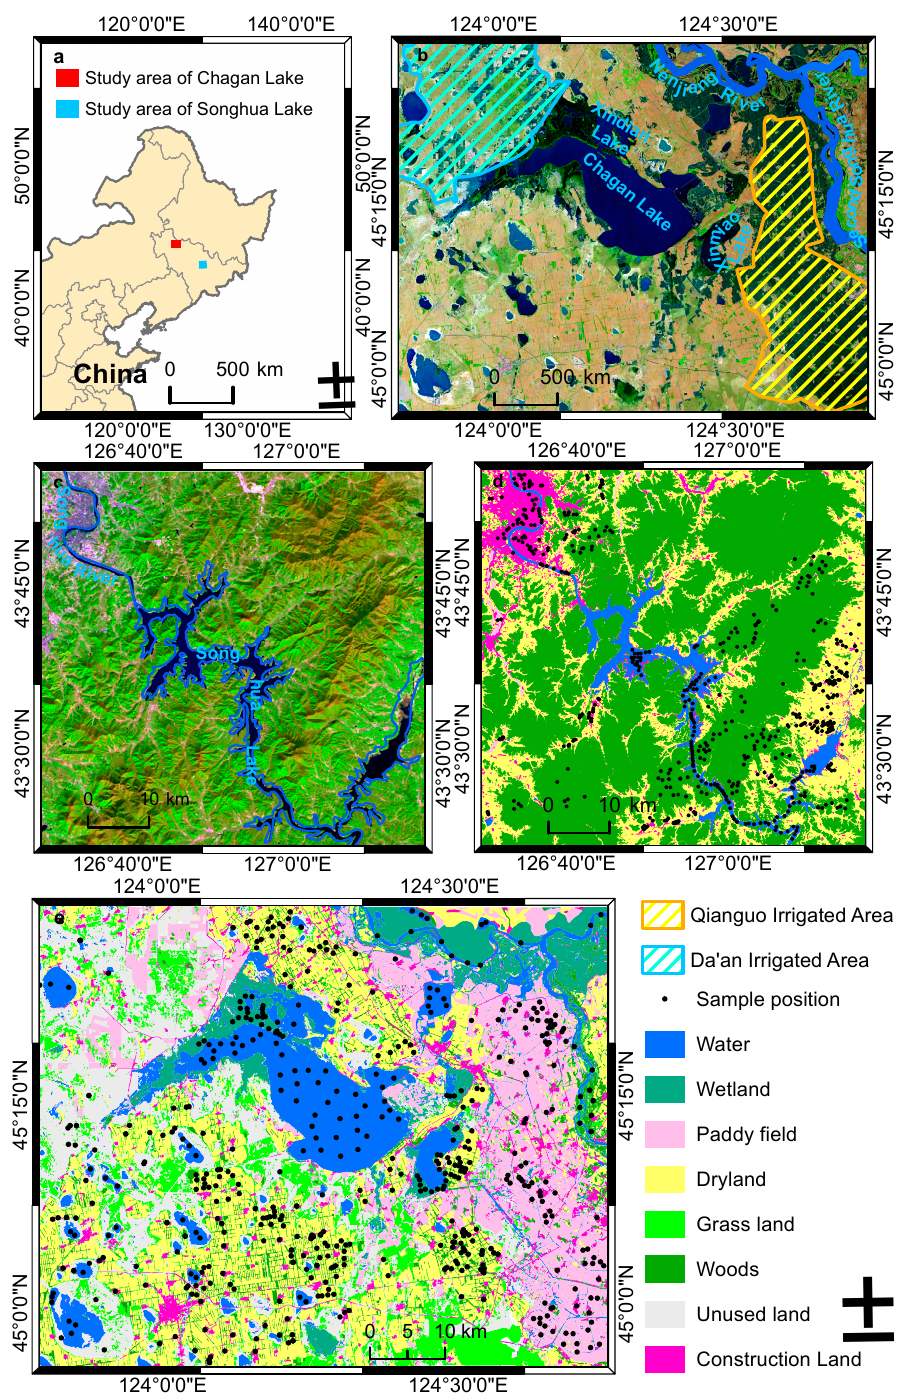
Figure 1. Location ( a ) surrounding river network and main irrigated areas ( b , c ) and land use types and sample position ( d , e ) of the two study areas.